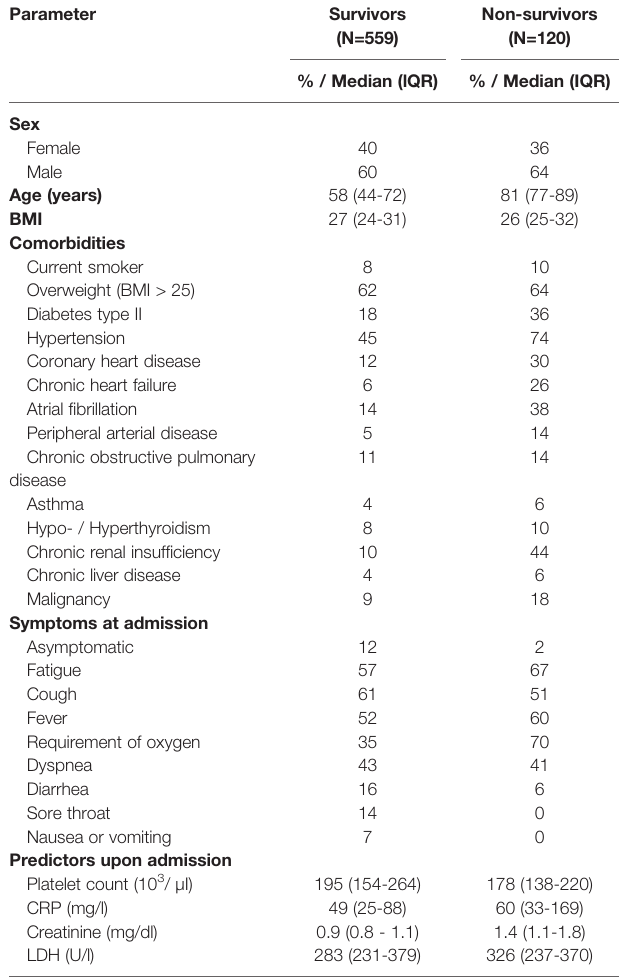
TABLE 1 | Patient characteristics development